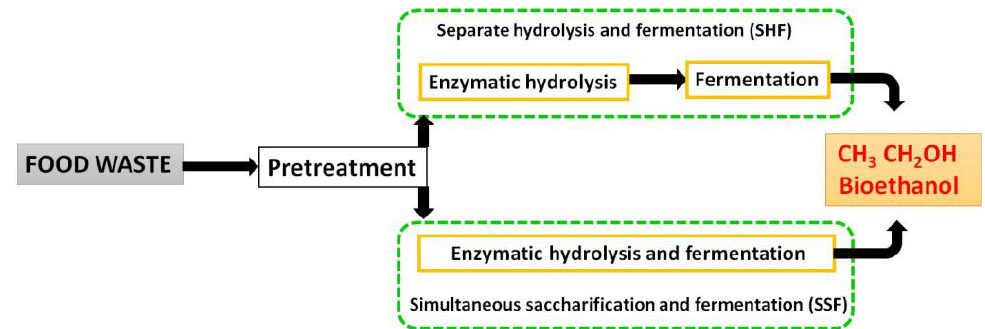
Figure 16. Production of Bioethanol from food waste through SHF and SSF processes.